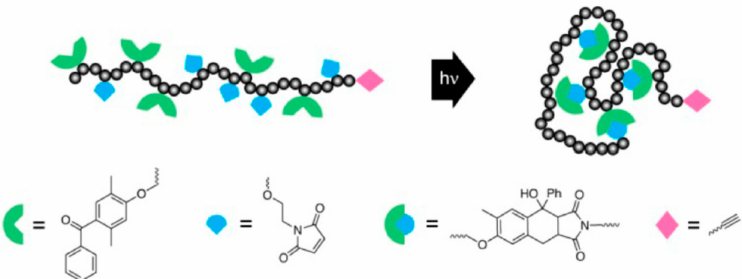
Figure 13. Functional SCNP formation via photoinduced Diels–Alder (DA) ligation using a precursor having 2,5-dimethyl benzophenone (in green color ) and N -maleimide pendants (in blue color ), and an alkyne functional group as the chain-end (in pink color ). Reprinted from [46] with permission.